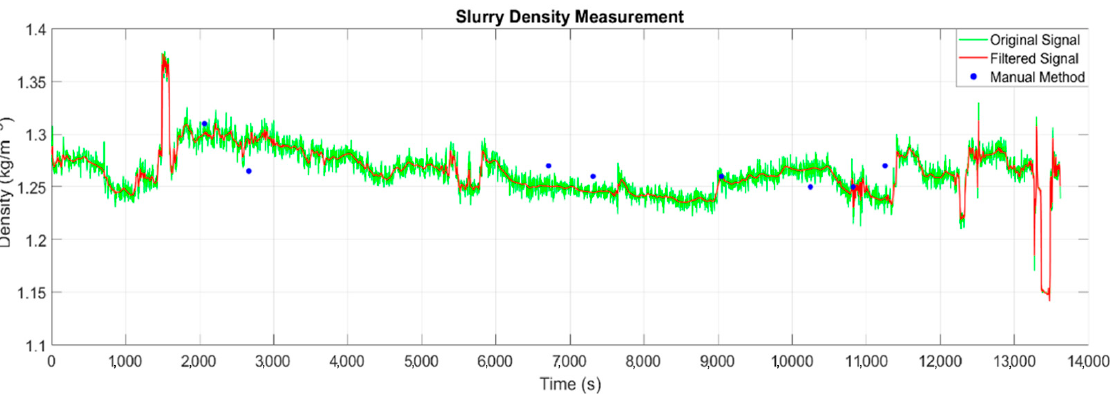
Figure 6. The results of the sediment density measurements over time: original signal (green line); signal after filtering with a wavelet filter (red line); results of manual measurements (blue dots).